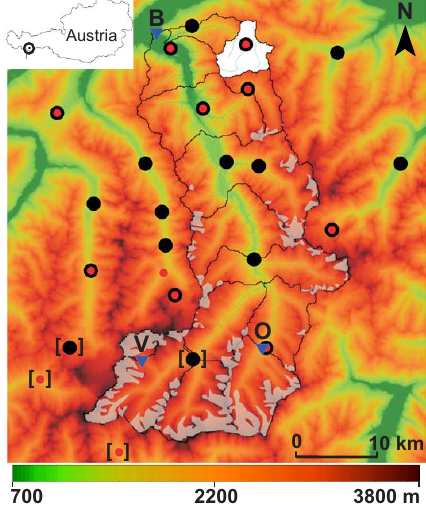
Fig. 1. Overview of ¨Otztaler Ache catchment including gauges (blue triangular) Brunau (B), Vernagtbach (V) and Obergurgl (O), pre- cipitation stations (black circles) and temperature stations (red cir- cles). Brackets mark the stations for which downscaled data were not available. Catchment and subcatchments are delineated in black. Due to a man made outlet one subcatchment was not contributing and in the modeling procedure not considered (white). Glacier cov- ered areas are presented in silver. Altitude ranges from 700ma.s.l. (green) to 3800ma.s.l.